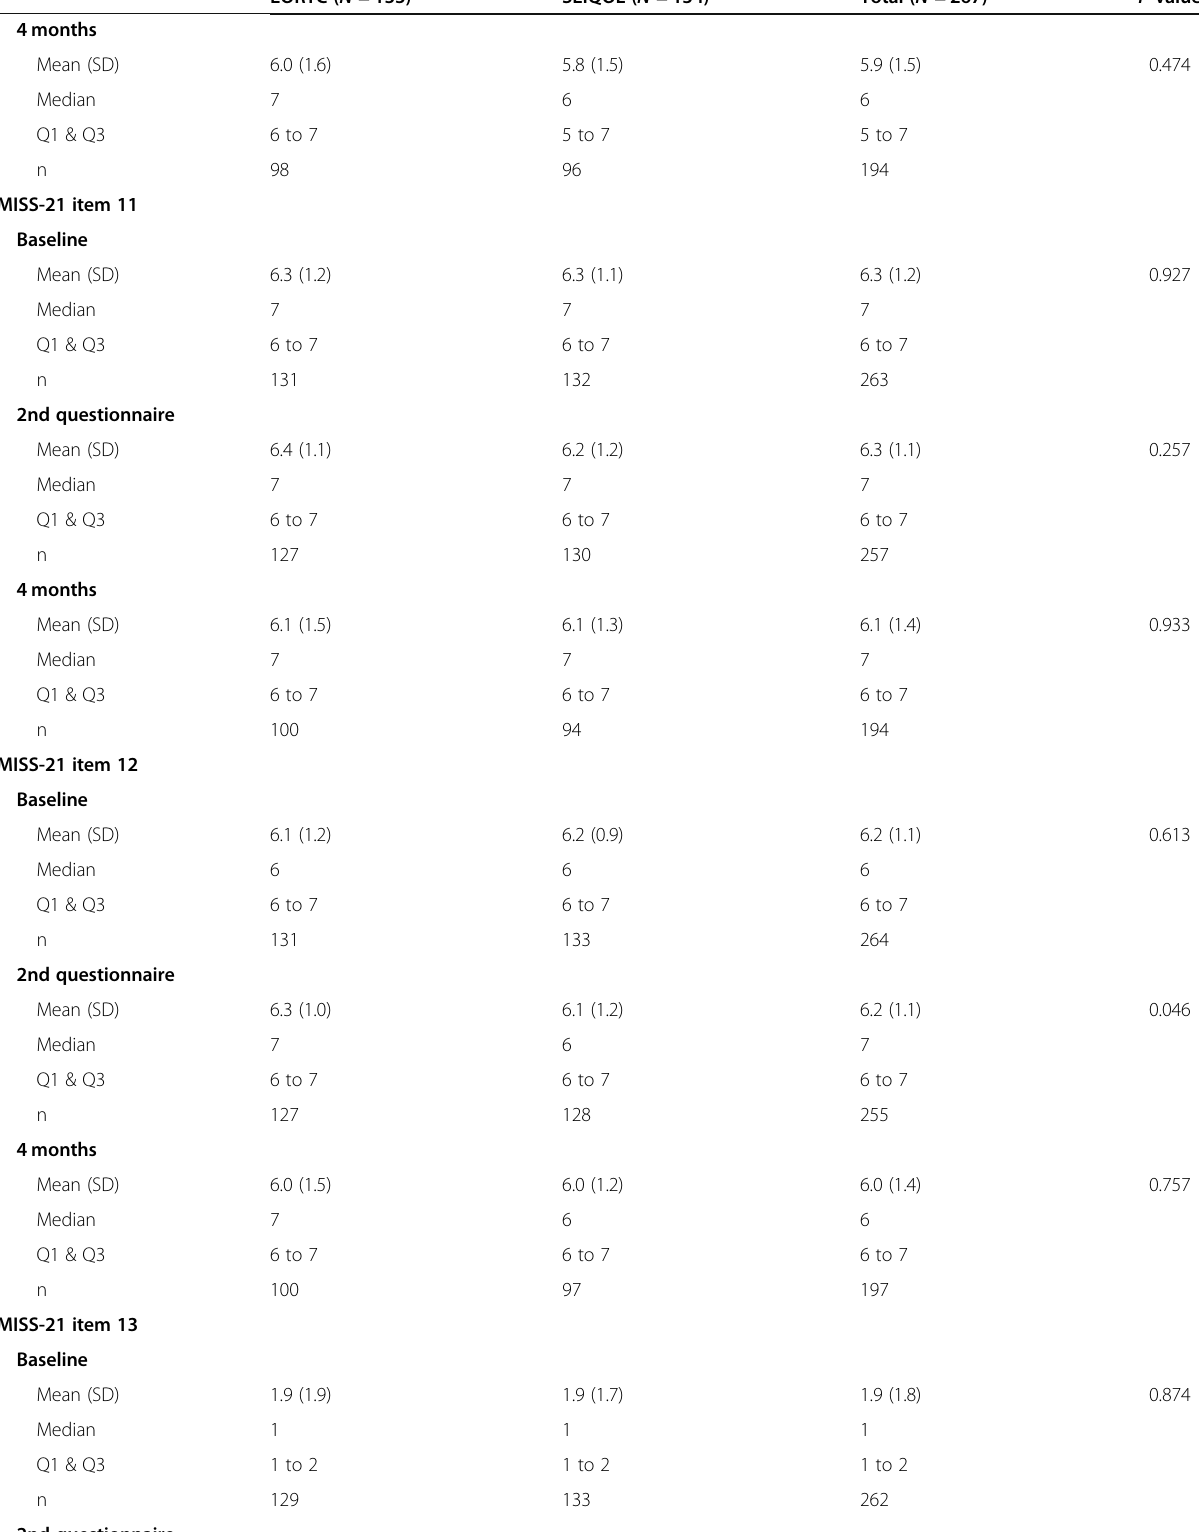
Table 2 Outcomes a over time for analyzed patients